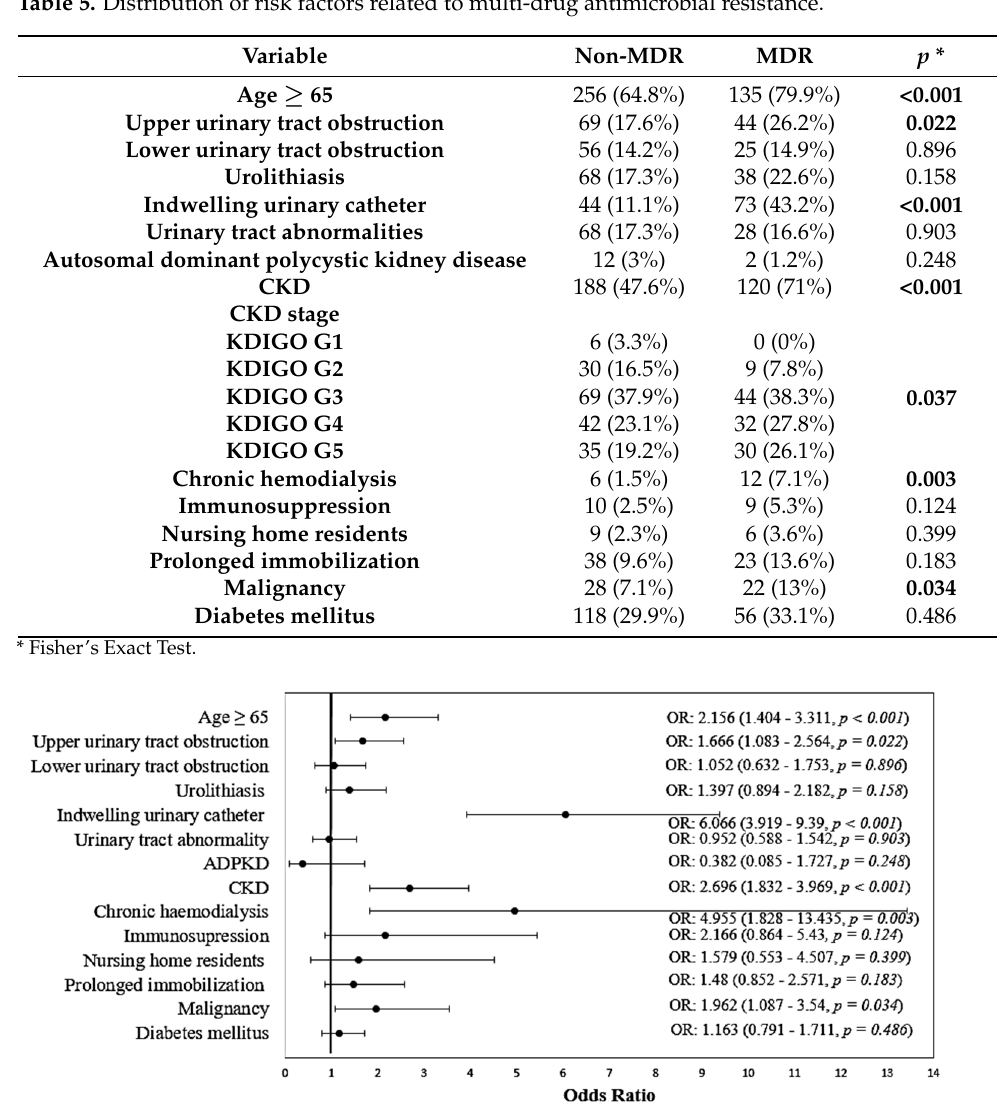
Figure 3. Forest plot for odds ratio with 95% confidence intervals–univariate analysis of risk factors for multi-drug antimicrobial resistance.